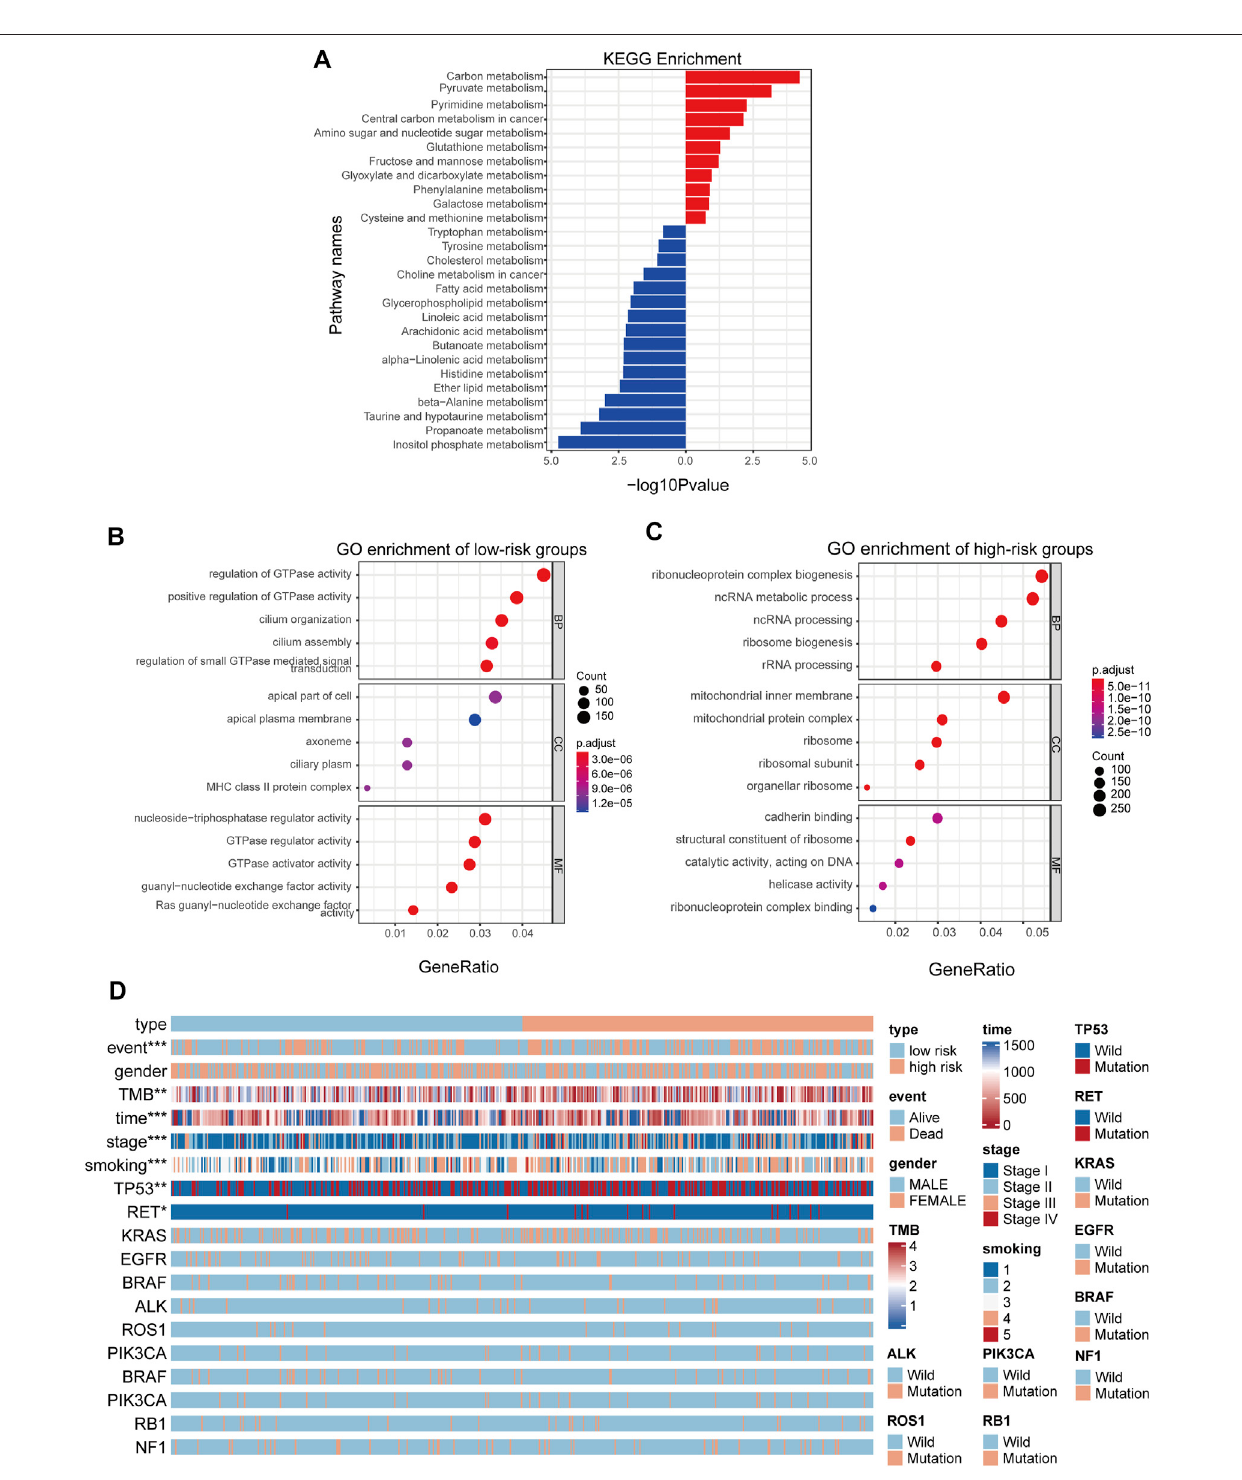
FIGURE 4 | MGRS can identify the survival status of different patients. (A) KEGG pathway enrichment analyses for differentially-expressed metabolic genes (B,C) GOpathwayenrichmentanalysesfordifferentially-expressedgenes.Pathwaysactivatedinlow-riskgroups (B) Pathwaysactivatedinhigh-riskgroups (C) areshown.All enriched pathways were signi fi cant. (D) A heatmap showed that clinical stage, survival status, smoking status, Tumor Mutational Burden (TMB), and gene mutations in TP53 and RET were signi fi cantly associated with risk.